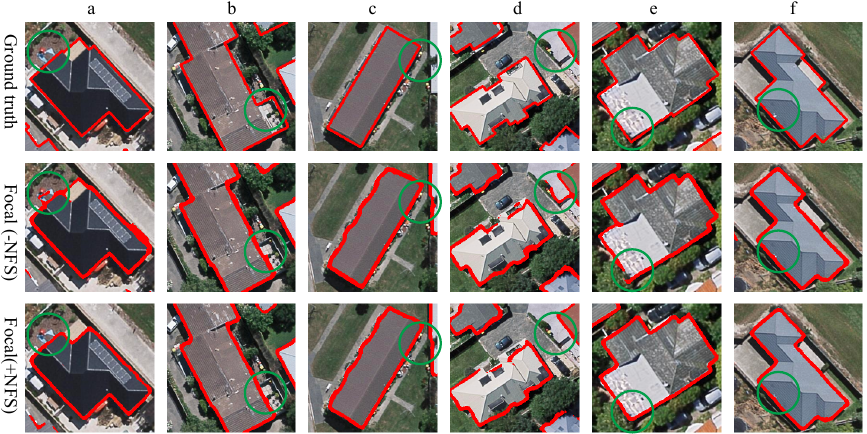
Figure 12. Representative results of outlines extracted from model trained by focal loss with/without nearest feature selector (NFS). Backgrounds, red lines, and green circles represent aerial input, predicted outline, and focused area, respectively.Selected results are denoted as ( a – f ).